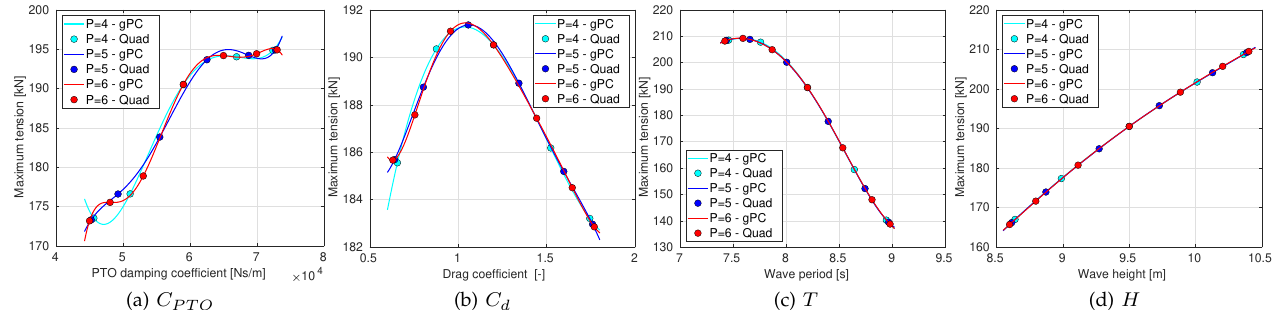
Fig. 5. Convergence of gPC surrogate models for the maximum tension in the mooring cable at the fairlead. ERW1 case using d = 1 .